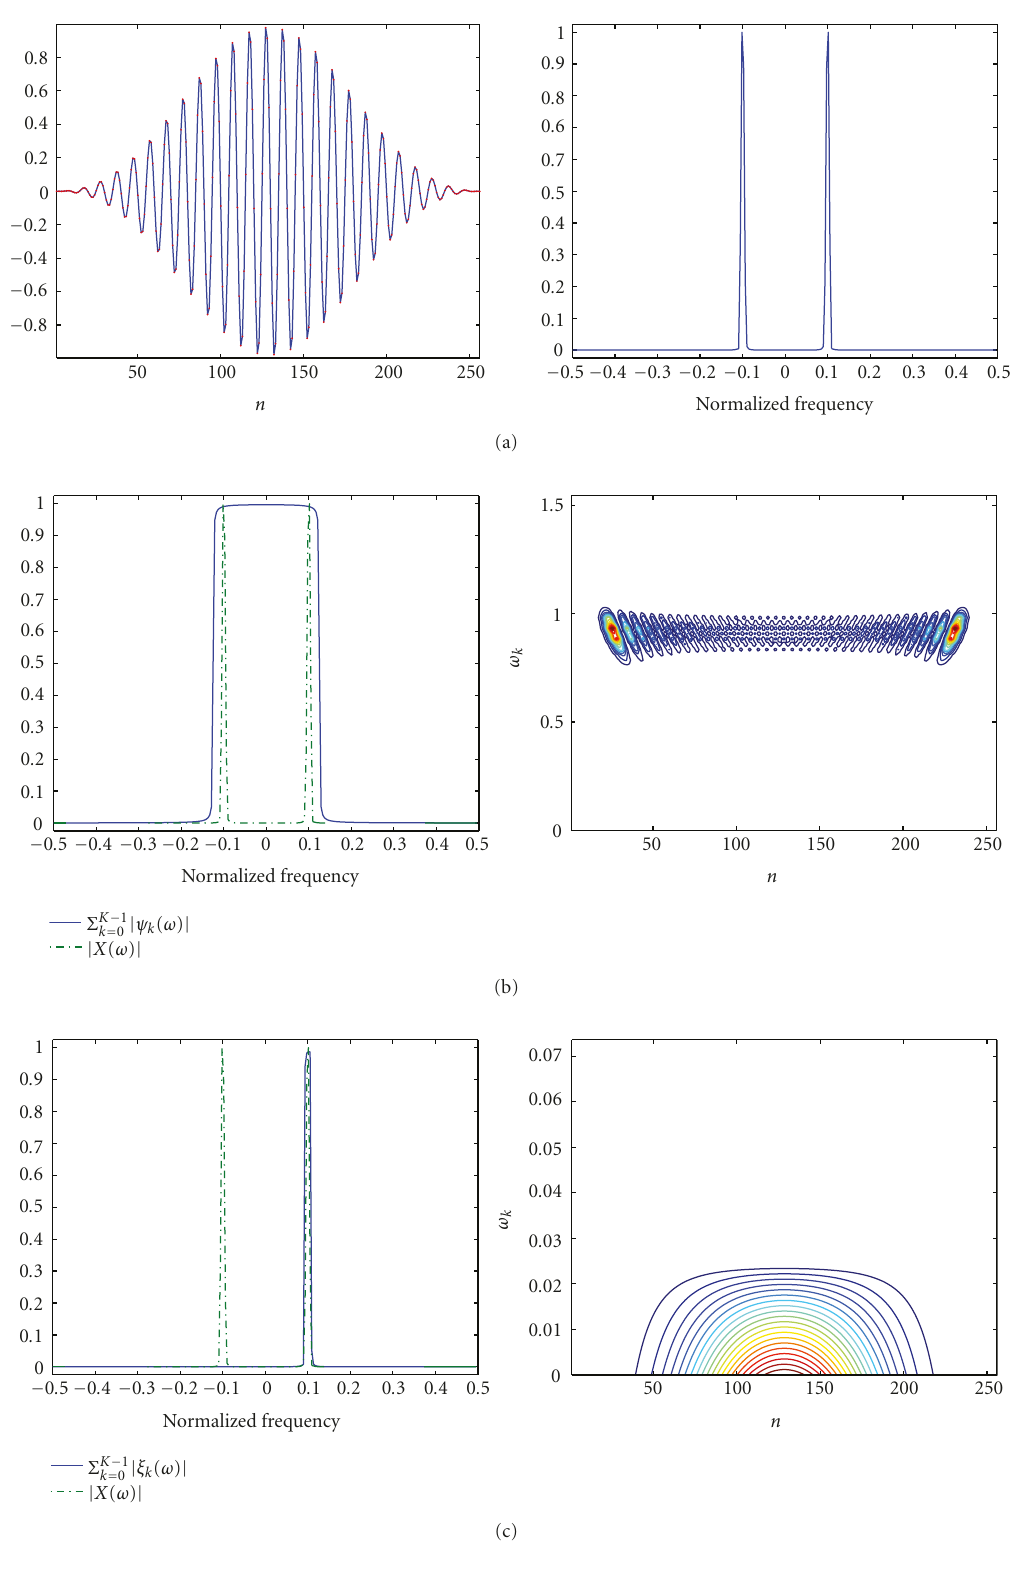
Figure 3: Comparison of evolutionary Slepian spectrum for passband test signal using baseband and bandpass DPSS. (a) x 2 ( n ) and its spectrum | X ( ω ) | , (b) spectrum of baseband DPSS ( K = 64) and corresponding | X ( n , ω k ) | 2 , and (c) spectrum of bandpass DPSS ( K = 4) and corresponding | G ( n , ω k ) | 2